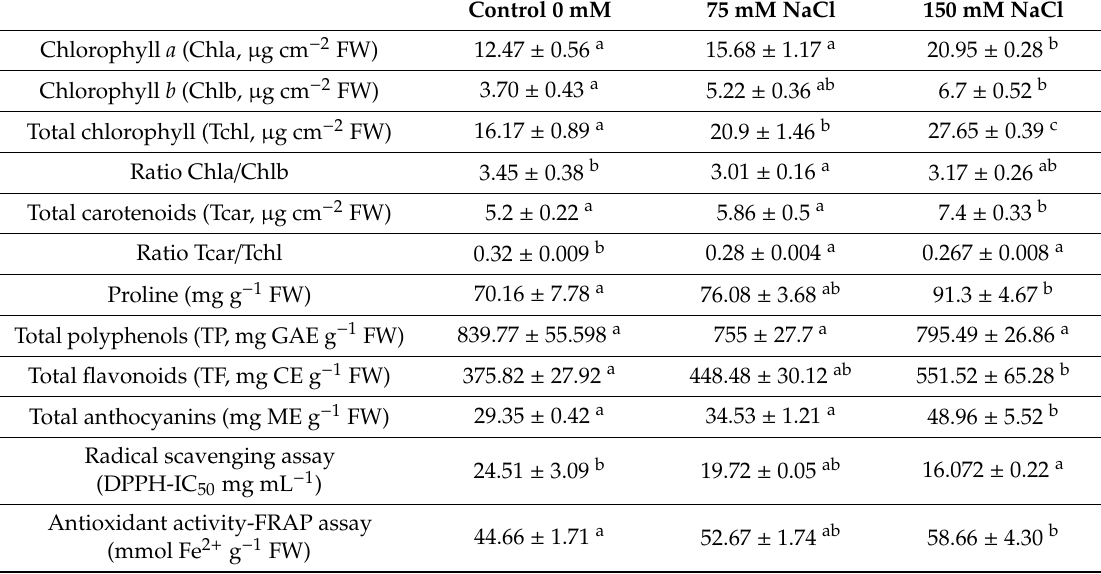
Table 2. Determination of pigments, secondary metabolites, and radical scavenger activity in the Lawsonia inermis leaves after treatment with di ff erent NaCl concentrations (0, 75, and 150 mM). Data are presented as means ± SE ( n = 3). Di ff erent letters indicate statistically significant di ff erences with Fisher’s probable least squares di ff erence test ( p ≤ 0.05). Abbreviations: GAE—gallic acid equivalents;